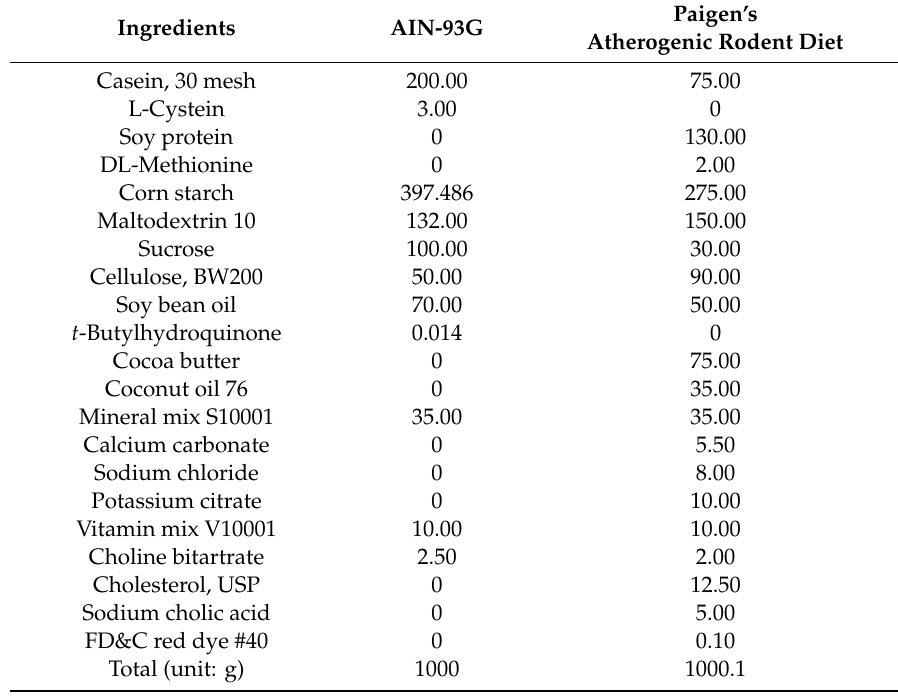
Table 2. Composition of the experimental diets fed to rats. The nutrition components are expressed as g / 1000